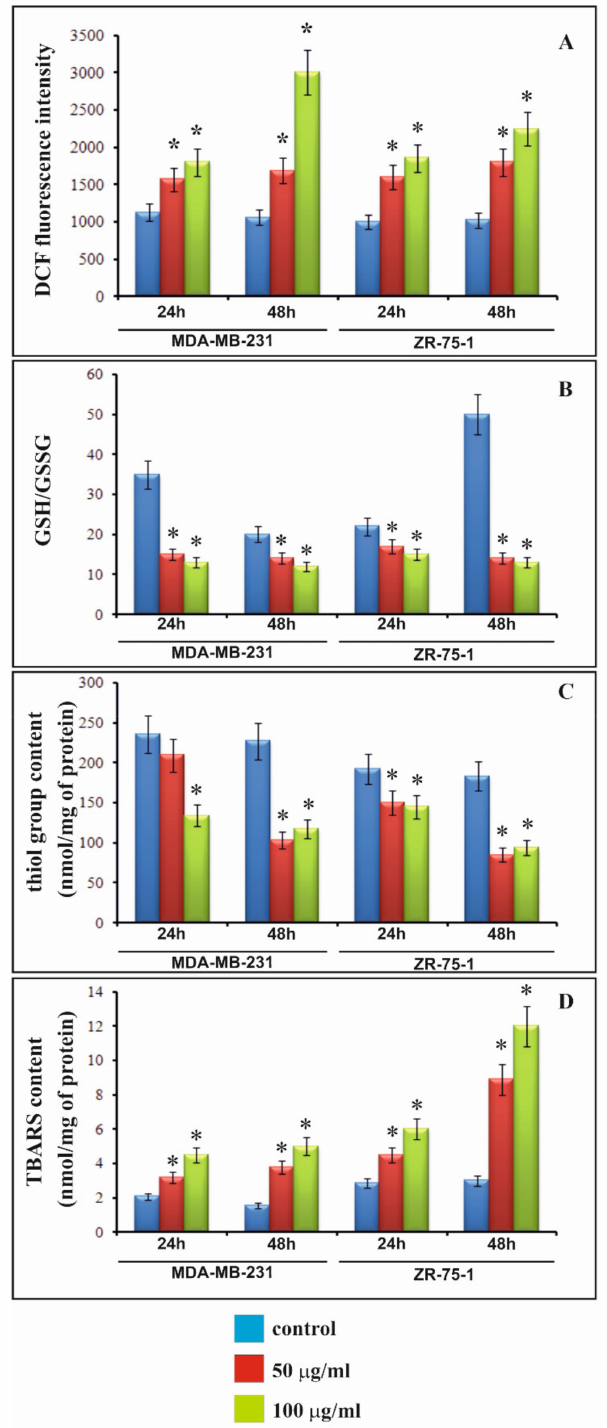
Figure 2. Oxidative stress and biochemical changes induced by rGO in MDA-MB-231 and ZR-75-1 cell lines. The cells were incubated with 50 µ g/mL or 100 µ g/mL rGO for 24 h and 48 h. Intracellular reactive oxygen species (ROS) production in MDA-MB-231 and ZR-75-1 cells is presented on panel ( A ). Panel ( B ) shows the GSH/GSSG ratio. The content of intracellular thiol groups is shown on panel ( C ), while panel ( D ) shows the TBARS content. Mean values from three independent experiments ± SD are presented. Significant alterations are expressed relative to the controls and marked with asterisks. Statistical significance was considered if * p <